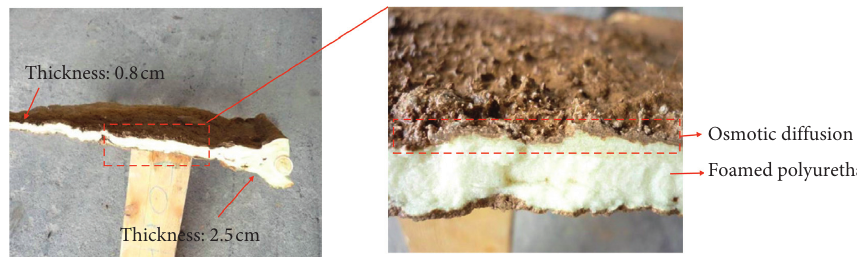
Figure 16: Split diffusion pattern of foaming polyurethane